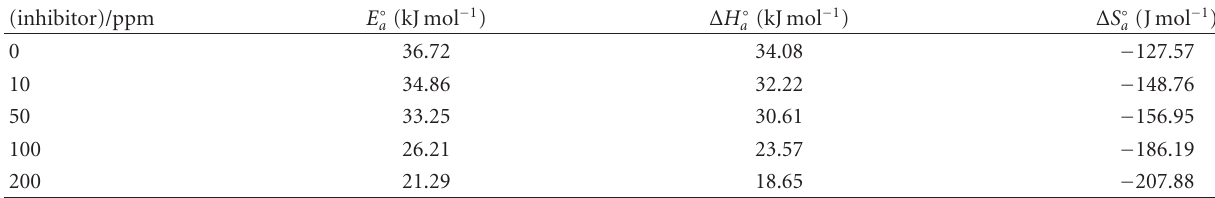
Table 4: Values of activation parameters for mild steel in 1M HCl in the absence and presence of di ff erent concentrations of the inhibitor. (inhibitor)/ppm